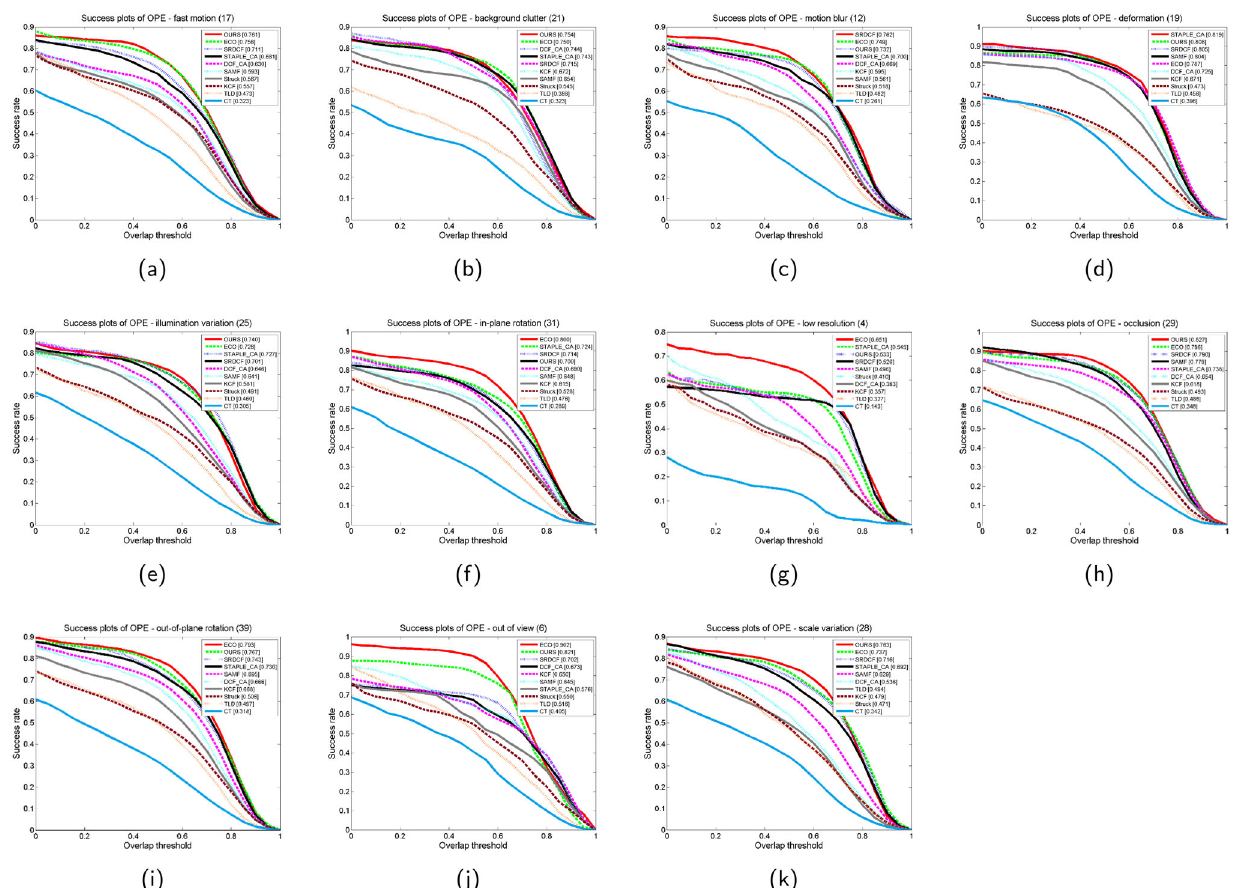
Fig. 8 The success rate score curve of 11 algorithms in the OTB-50 dataset